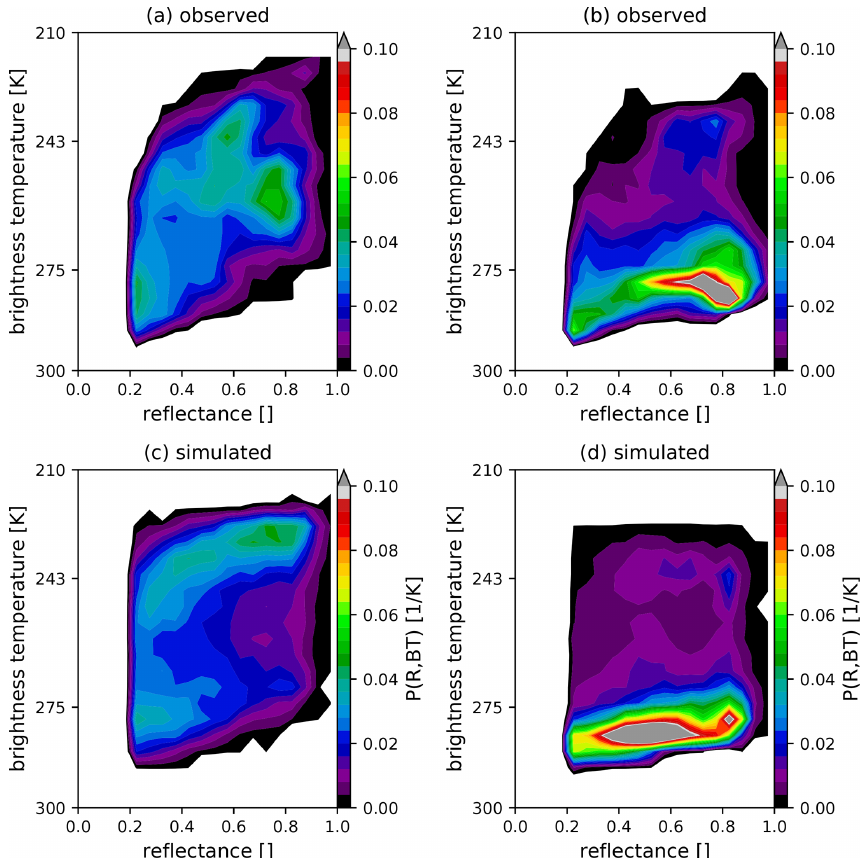
Figure 7. Combined 0.6µm SEVIRI solar reflectance (VIS006) and 10.8µm SEVIRI brightness temperature (IR108) PDF of observa- tions (a, b) and simulations (c, d) on 29 May (a, c) and 2 June 2016 (b, d) at 12:00UTC.